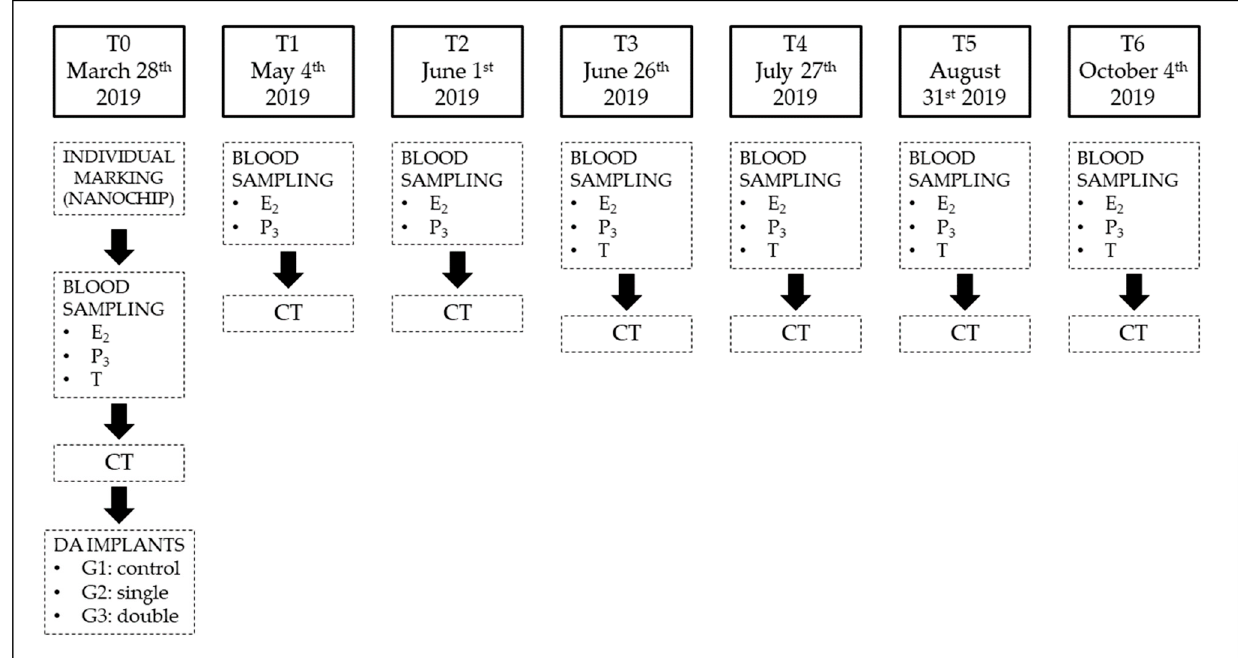
Figure 1. Flowchart illustrating the experimental methodology of the present study. E 2 = estradiol; P 3 = progesterone; T = testosterone; G1 = group 1; G2 = group 2; G3 = group 3.